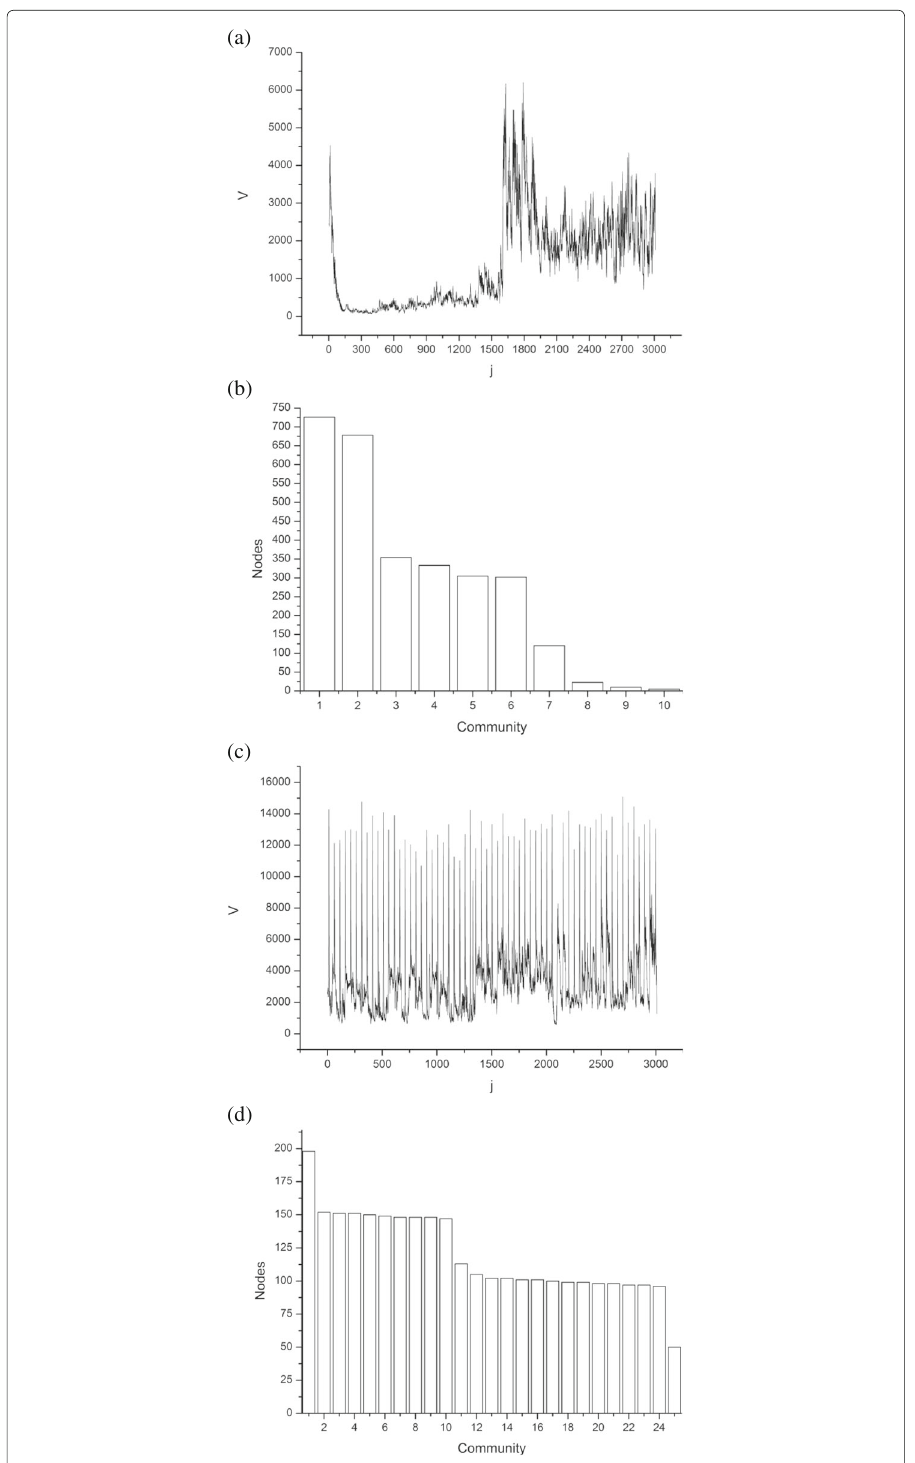
Fig. 6 Variance fluctuations of two audio samples and their respective distributions of nodes per community, obtained from the visibility networks created by mapping these fluctuations. Source: Author. a Variance fluctuation series of Symphonic track 24 (Mozart’s Symphony 41 (k 551)). b Distribution of nodes per community of the Symphonic track 24 visibility network. c Variance fluctuation series of Percussive track 4 (song “Run Back” by Carl Douglas). d Distribution of nodes per community of the Percussive track 4 visibility